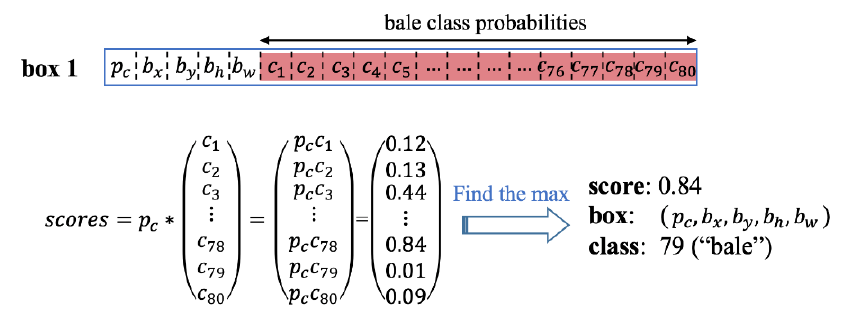
Figure 4. Example of generating the probability of a certain class in each bounding box.